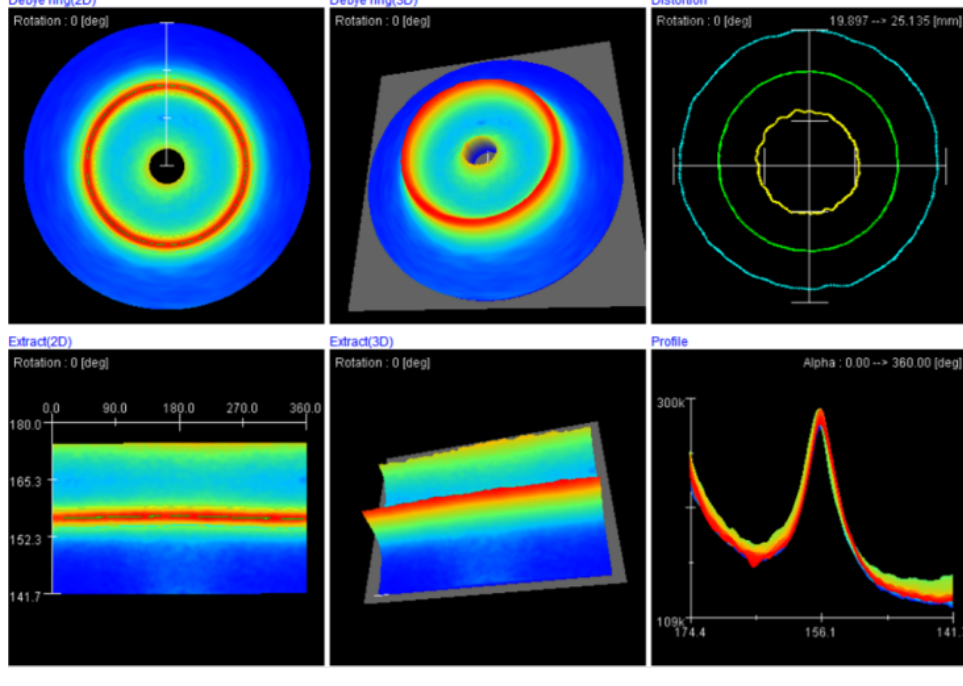
Figure 11. D-S ring information for the case with a laser power of 500 W.